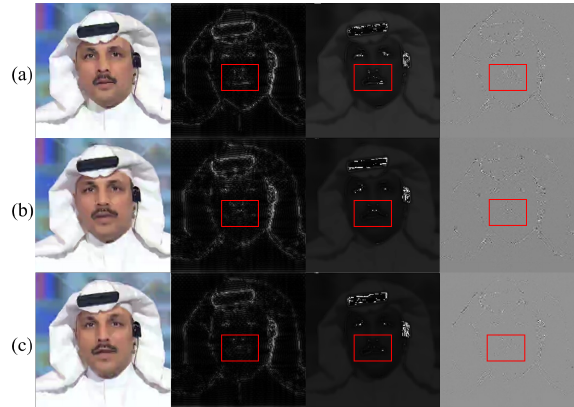
Figure 1. Frequency domain analysis of highly compressed face images: ( a ) real face images; ( b ) fake face images by neural textures; ( c ) fake face images by Face2Face. The forged images ( b , c ) lack some textures and boundary information of the real images ( a ), especially in the area containing the nose and mouth.